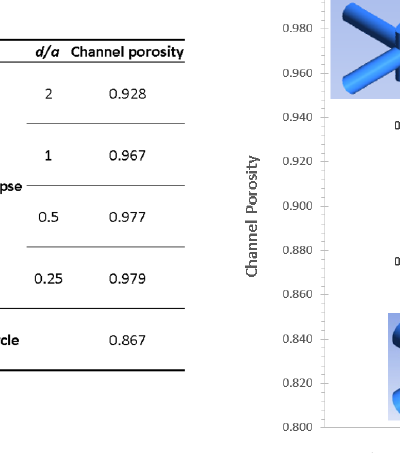
Figure 4. The pillar-like feed spacer’s porosity.